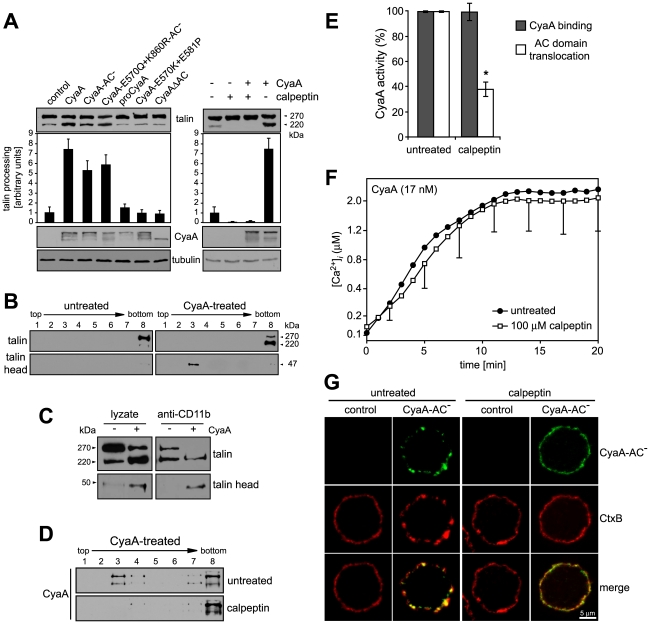
Mobilization of CyaA into lipid rafts depends on talin cleavage by calpain.(A) J774A.1 cells were incubated with 30 nM CyaA proteins at 37°C for 10 min (left panel). Talin, CyaA and α-tubulin were detected in cell lyzates by Western blotting using 8d4, 9D4 and Tu-01 MAbs, respectively. Calpain activation was inhibited by preincubation of cells with 100 µM calpeptin at 37°C for 30 min (right panel). Talin processing was determined from Western blots as relative increase of the amount of the 220-kDa talin fragment, taking the value for untreated cells as 1. Data represent the mean ± S.D. from three experiments. (B) Cells were kept in buffer or pretreated with 100 µM calpeptin at 37°C for 30 min before incubation with 1 nM CyaA at 37°C for 10 min. Talin, talin head and CyaA were detected in cell lyzates separated on sucrose density gradients using 8d4, TA-205 and 9D4 MAbs, respectively. The shown blots are representative of four independent experiments. (C) CyaA-mediated talin cleavage promotes CD11b/CD18 release from cytoskeletal constraints. J774A.1 cells were incubated with 30 nM CyaA for 30 min at 37°C. Cell lyzates were prepared and incubated with anti-CD11b monoclonal antibody (MEM-174) covalently coupled to CNBr-activated Sepharose beads. The beads were washed, bound proteins were eluted with SDS-PAGE loading buffer, and talin and talin head were detected by Western blotting with 8d4 and TA-205 antibody, respectively. (D) DRM association of CyaA in J774A.1 cells kept in buffer or preincubated with 100 µM calpeptin was analyzed as above. (E) AC translocation into control and calpeptin-pretreated J774A.1 cells were determined as described in the legend to Fig. 3. (F) CyaA-mediated influx of Ca2+ into untreated and calpeptin-pretreated J774A.1 cells was measured as in Fig. 2. Values represent the mean ± S.D. of three independent experiments. An asterisk indicates a statistically significant difference (*, p<0.05; Student's t test). (G) J774A.1 cells grown on coverslips were kept in buffer or pretreated with 100 µM calpeptin at 37°C for 30 min before membrane distribution of fluorescently labeled CyaA-AC− (6 nM, green) and CtxB (5 µg/ml, red) was visualized as described in the legend to Fig. 2.